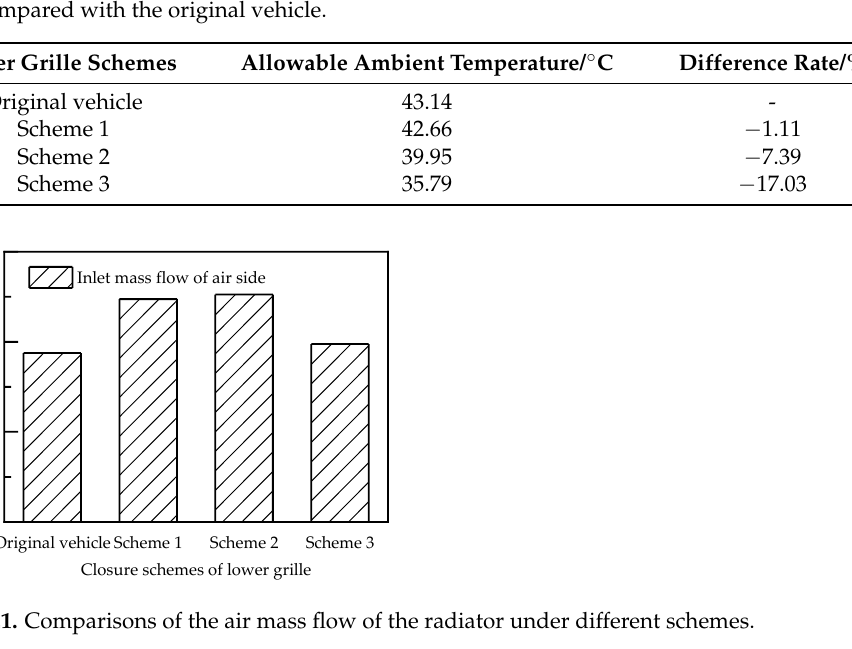
Figure 21. Comparisons of the air mass flow of the radiator under different schemes.